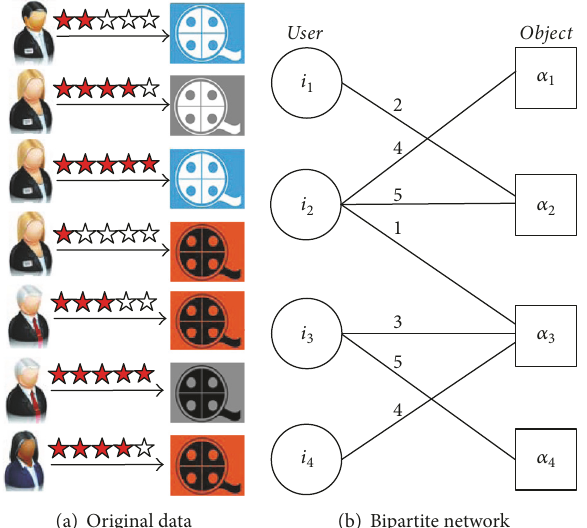
Figure 1: An example of how to construct a user-object bipartite network based on a collection of rating data [9]. (a) A real scene in which users see movies and vote on them in five discrete ratings 1–5. (b) The corresponding bipartite network, in which users and objects are represented by circles and squares,